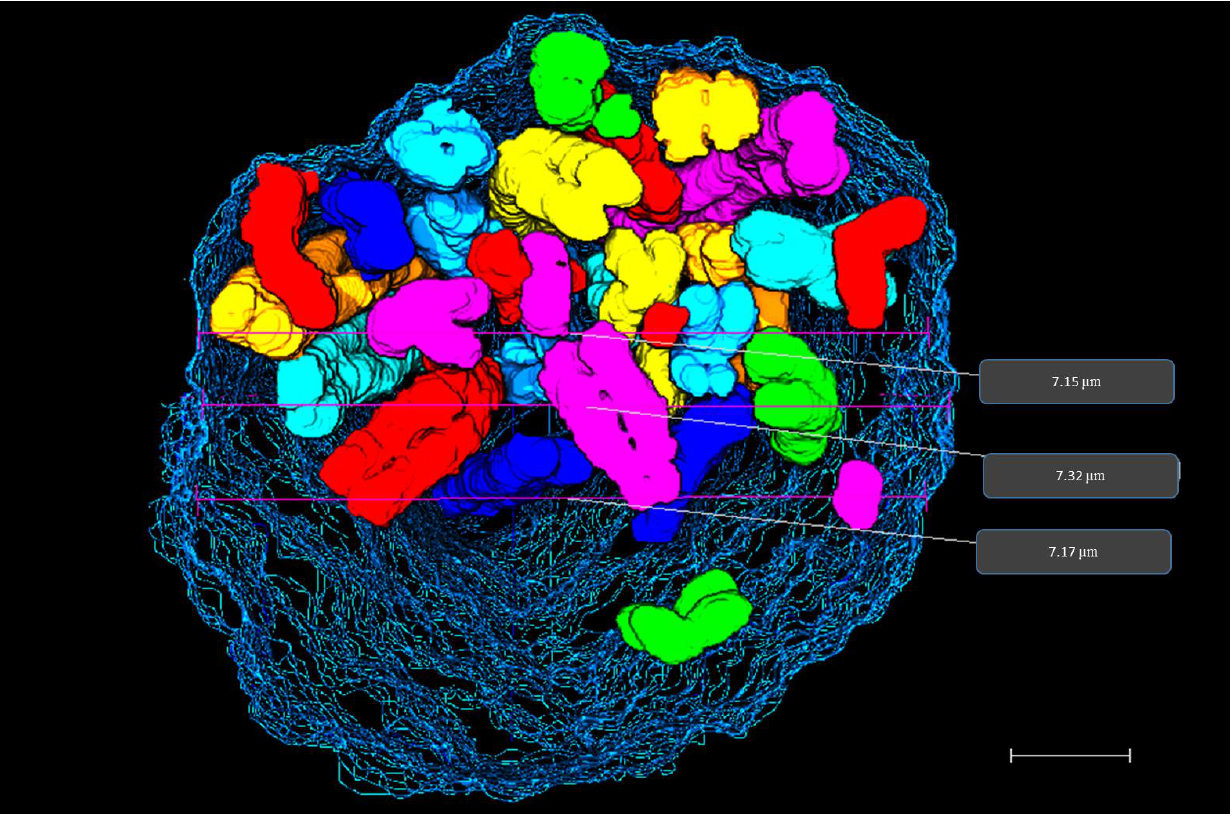
Figure 6. 3D prophase nucleus. 3D rendering of prophase nucleus showing chromosomes enclosed within the nuclear membrane reconstructed from SBFSEM data stack. Diameter measurements of prophase nucleus are displayed on the rendered data in grey boxes. Scale bar—1 µm.